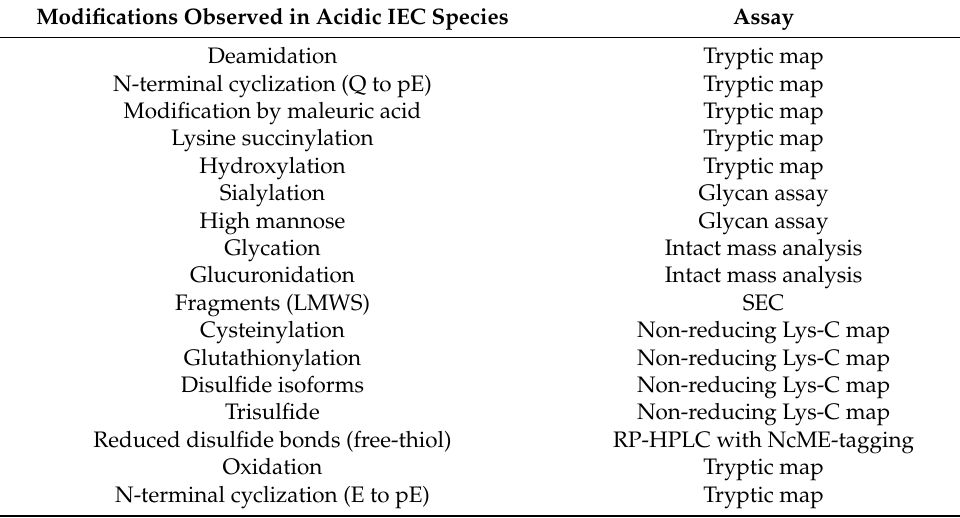
Table 2. Recommended Assays to Monitor and Quantify Acidic Variants.